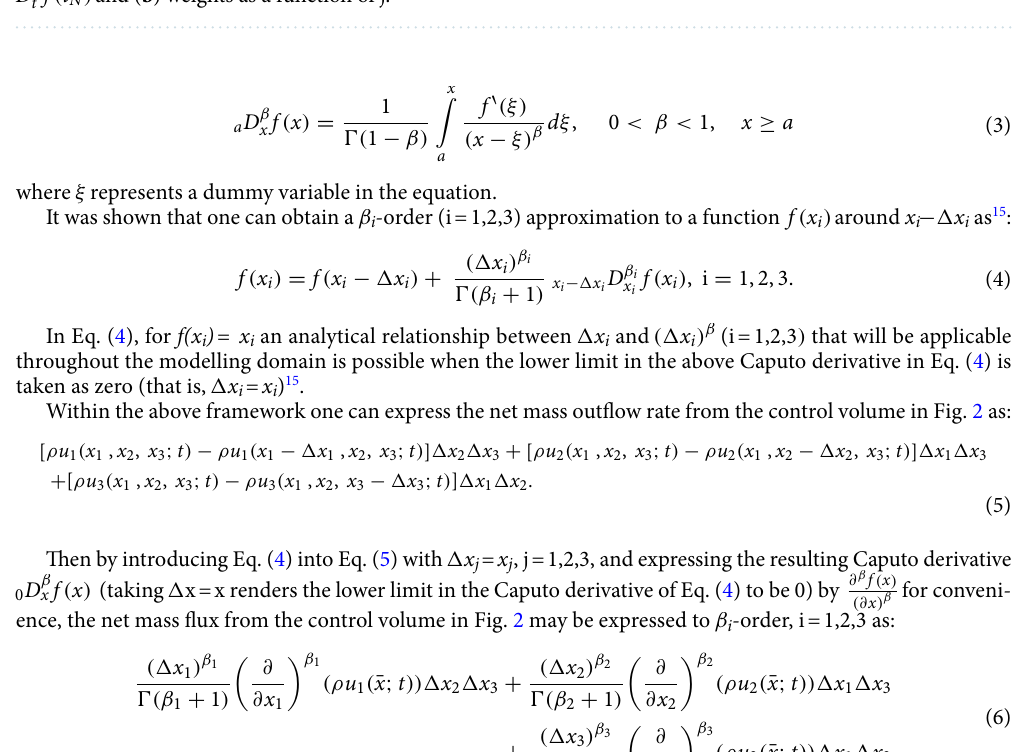
Figure 1. ( a ) Schematic description of weights w f ( t N ) and ( b ) weights as a function of D α t